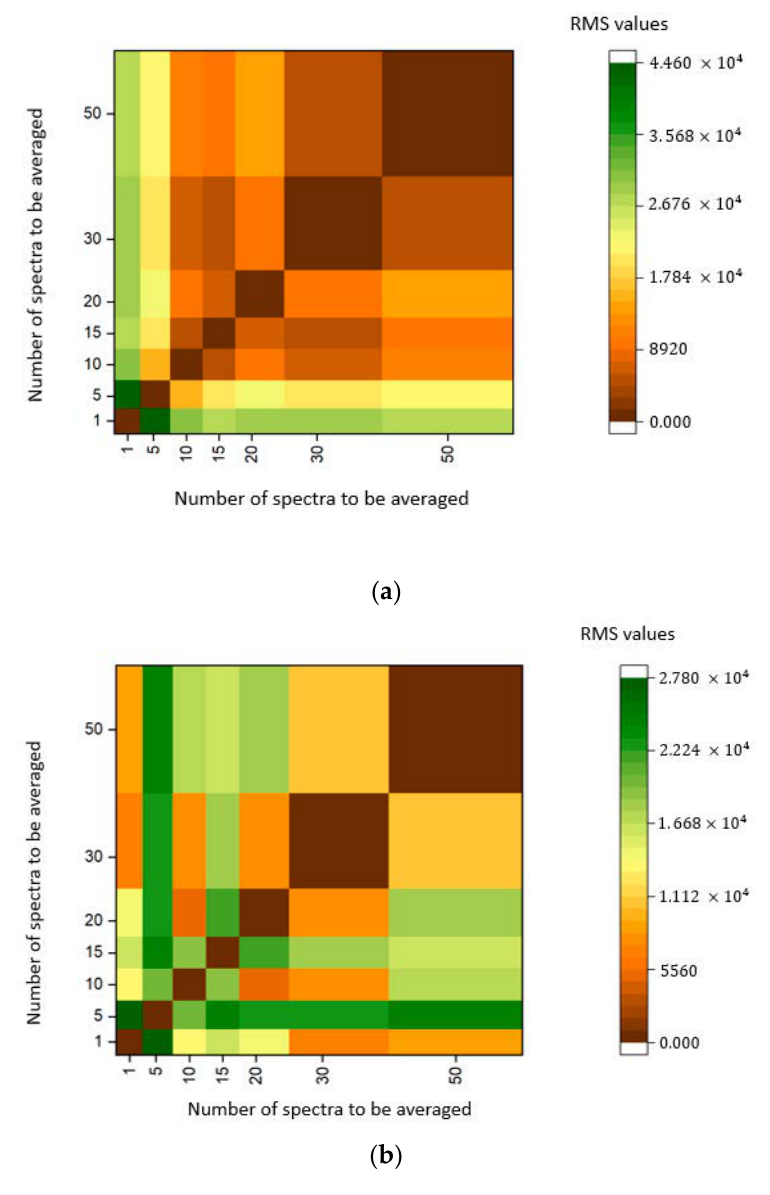
Figure 11. Heatmap showing the Root Mean Square (RMS) values for each number of scans to be averaged. ( a ) Heatmap with the RMS values using the Column scan model; ( b ) heatmap with the RMS values using the Hadamard scan model.